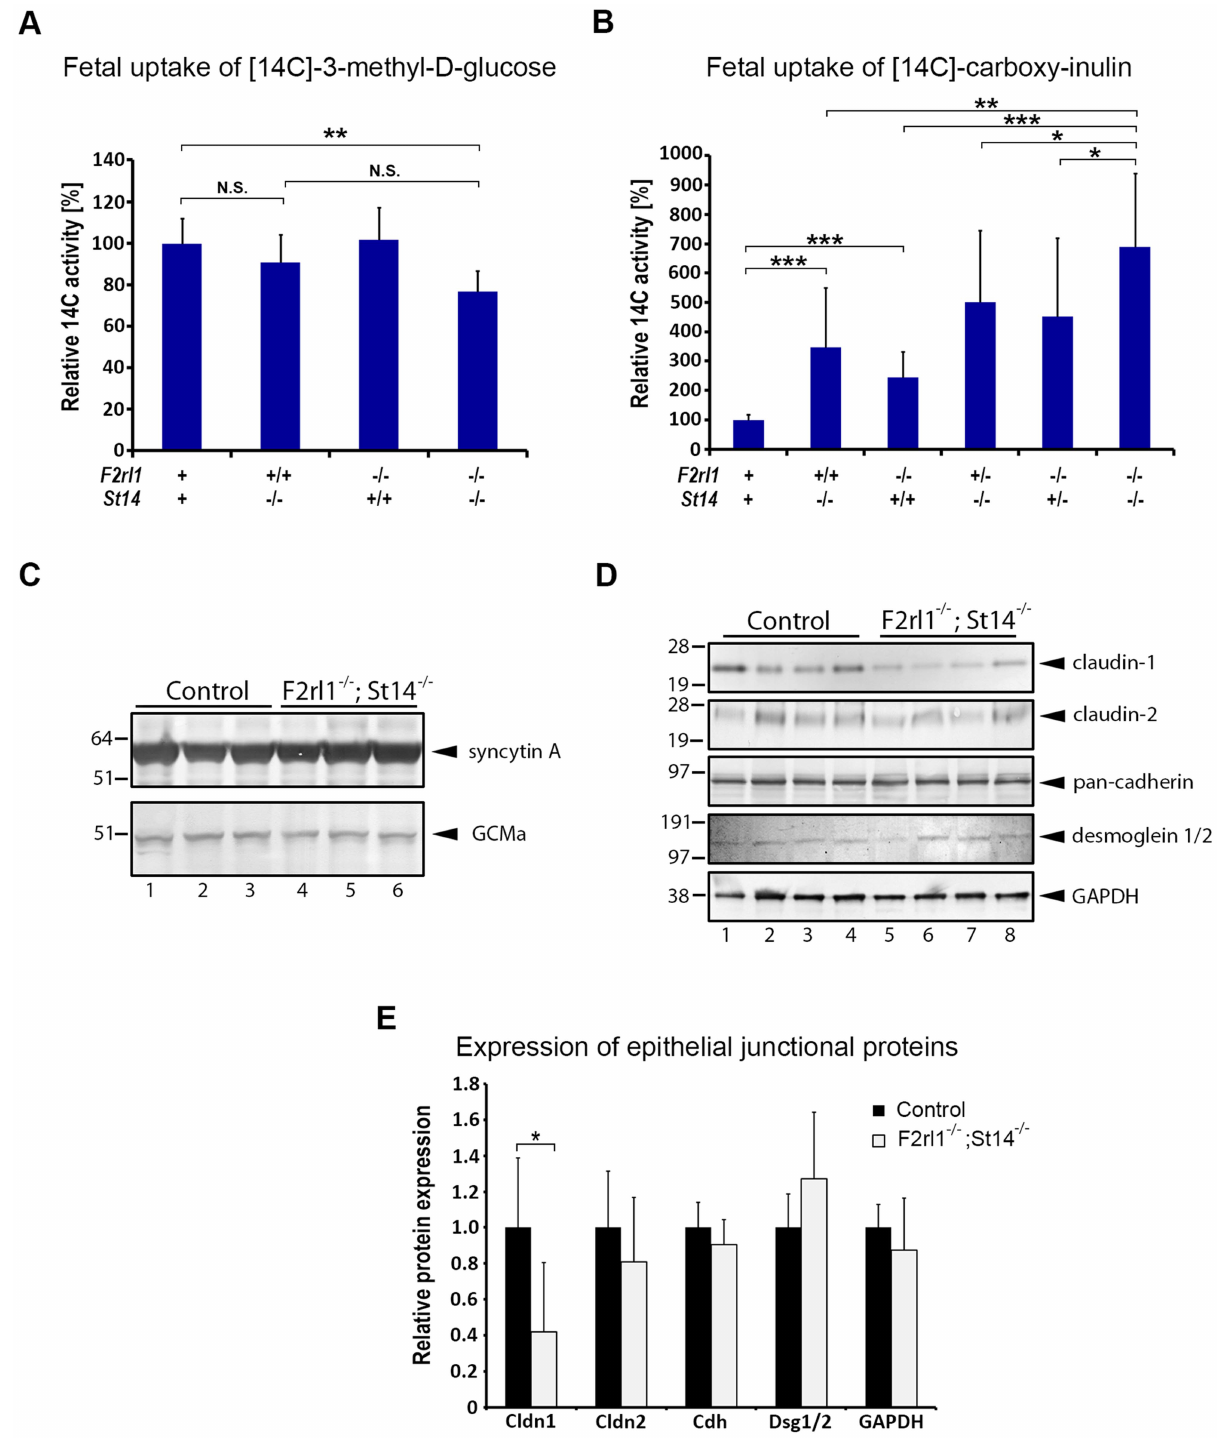
Figure 5. Loss of matriptase and PAR-2 function impairs formation of the feto-maternal barrier. ( A ). Relative uptake of the transcellular transport marker 3-methyl-D-glucose injected into the maternal bloodstream by E12.5–13.5 embryos. Placentas of matriptase ( F2rl1 + / + ,St14 2 / 2 ) or PAR-2 ( F2rl1 2 / 2 ;St14 + / + ) single-deficient embryos supported glucose transport at a rate comparable to the wildtype littermate controls ( F2rl1 + ;St14 + ), whereas matriptase and PAR-2 double-deficient mice ( F2rl1 2 / 2 ;St14 2 / 2 ) showed about 20% decrease in the glucose uptake (P , 0.01). ( B ). Relative uptake of the paracellular transport marker carboxy-inulin injected into the maternal bloodstream by E12.5–13.5 embryos. Diffusion of carboxy-inulin across the placental epithelium was strongly dependent on gene dosage of both matriptase and PAR-2, showing 247% and 145%, respectively, increase in St14 2 / 2 and F2rl1 2 / 2 single-deficient embryos, and 402% and 351% increase, respectively, in F2rl1 + / 2 ;St14 2 / 2 and F2rl1 2 / 2 ;St14 + / 2 embryos, compared to the wildtype littermate controls. Highest levels of inulin transfer across the placenta, 589% above the control, was observed in mice with a combined matriptase and PAR-2 deficiencies ( F2rl1 2 / 2 ;St14 2 / 2 ). ( C ). Expression of placental labyrinth differentiation markers syncytin A